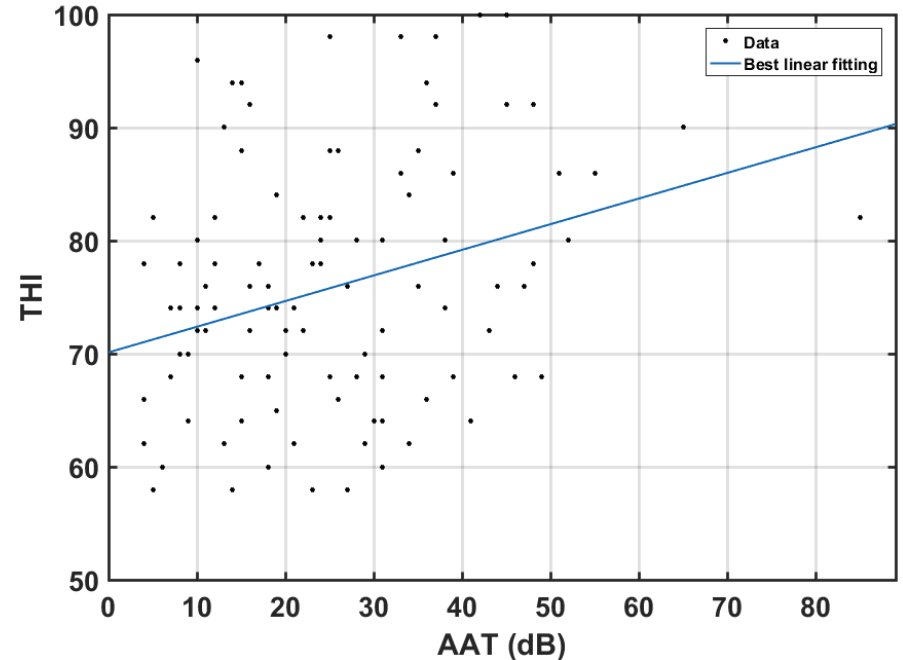
Figure 5. Scatter plot of tinnitus severity versus AAT for the decompensated subgroup.